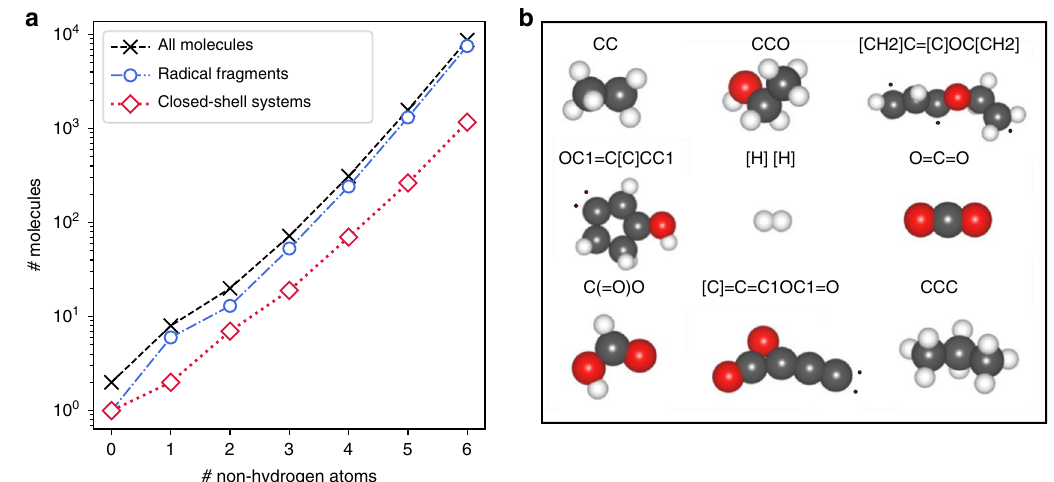
Fig. 2 The Rad-6 database. a Number of molecules in the database, according to their number of non-hydrogen atoms. b Structures of representative molecules in the database. Dots indicate radicals and respective SMILES strings